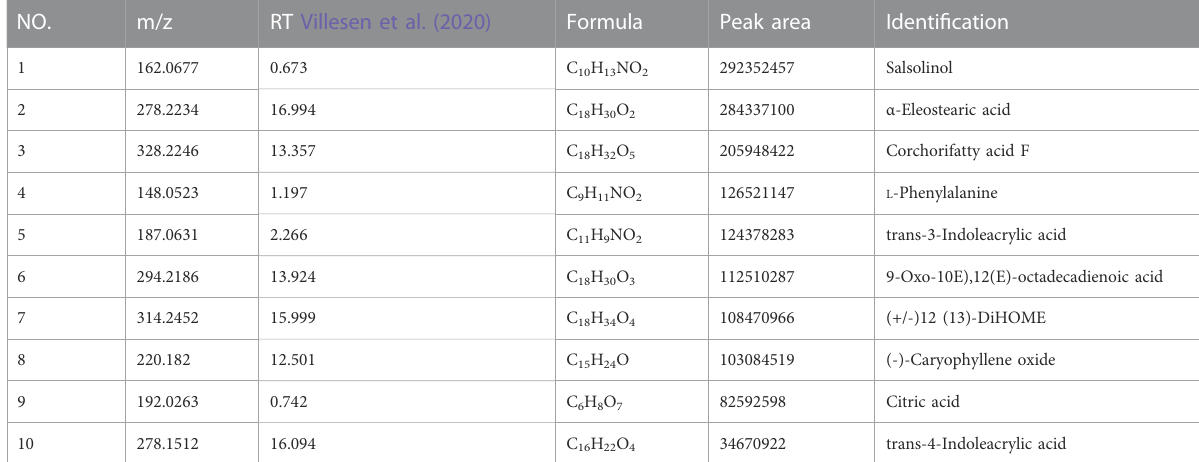
TABLE 2 Identi fi cation of the chemical constituents in